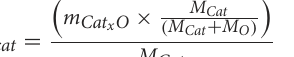
Column filling mass (g)